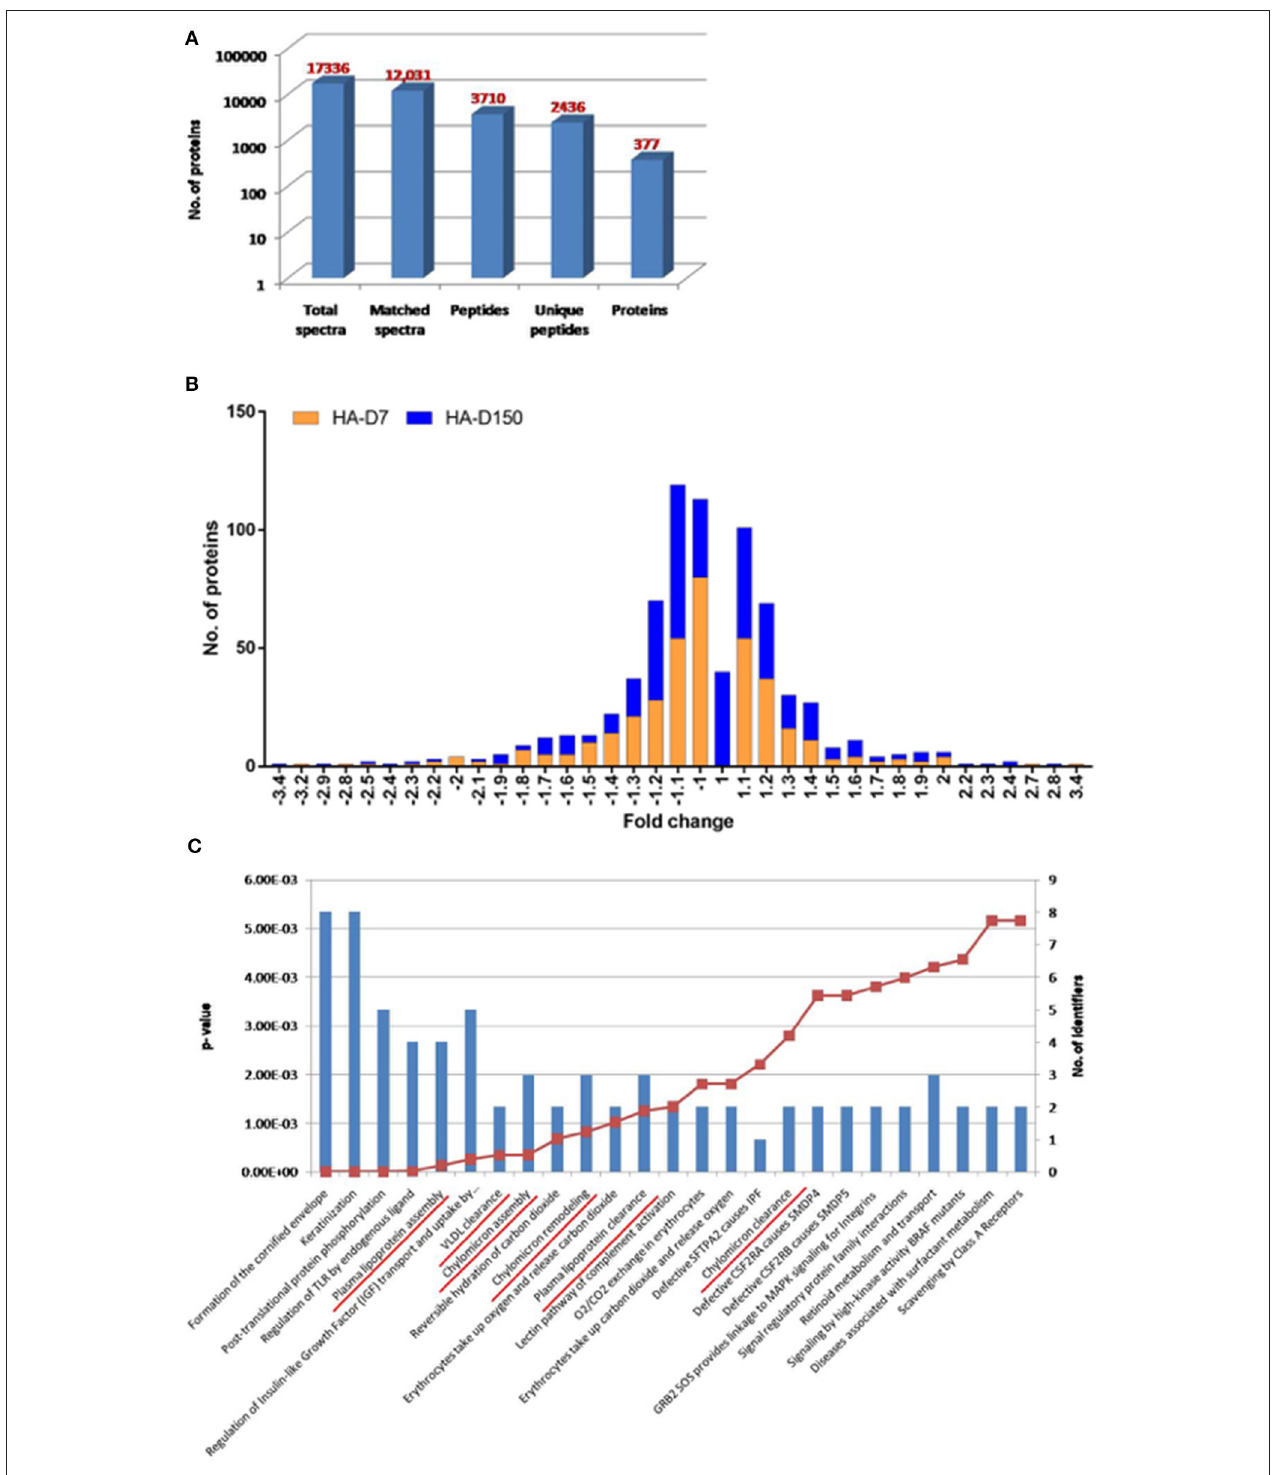
FIGURE 1 | TMT based plasma proteomics analysis. (A) Bar graph representing spectra, peptides, and proteins identified from TMT-based LC-MS/MS. (B) The quantitative ratio histogram of quantitative proteins identified in the study groups (HA-D7 and HA-D150 with respect to sea level). (C) Top 25 significant pathways for the identified common upregulated proteins in HA-D7 and HA-D150 groups representing a number of identified proteins along with their p -value. Underlined signify identified pathways involved in lipoprotein metabolism.